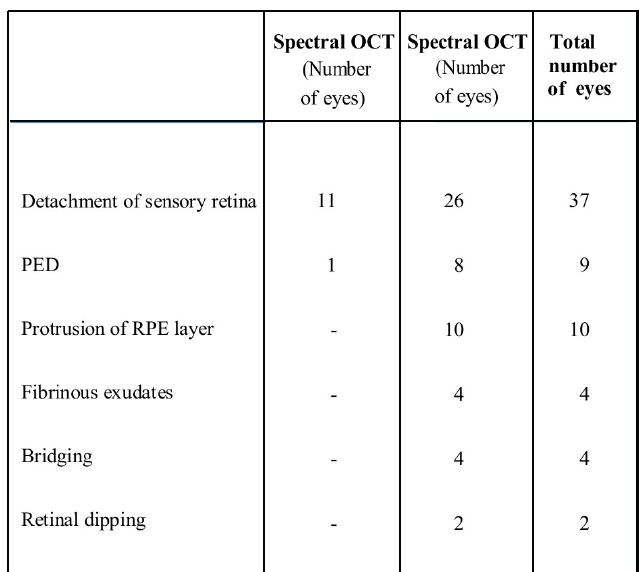
Table 1: Optical Coherence Tomography (OCT) characteristics of acute central serous chorioretinopathy